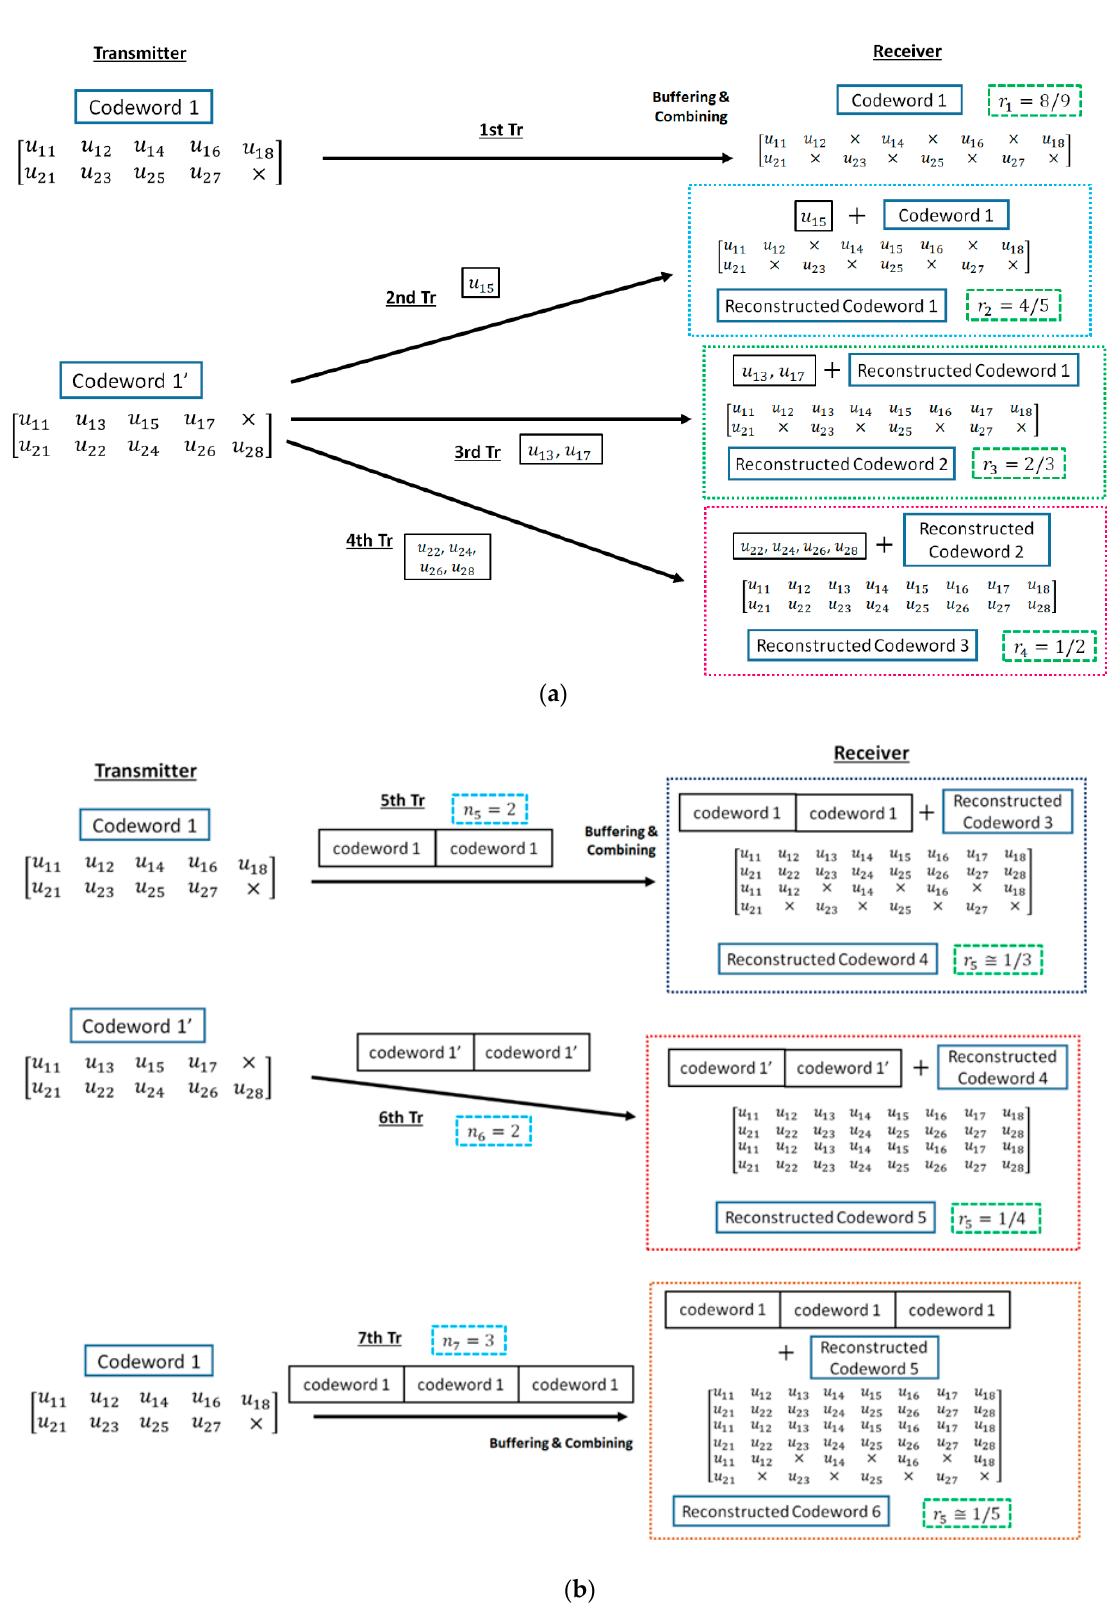
Figure 4. Method of reconstructing decomposable codes. ( a ) 1/2 ≤ r i ≤ 8/9; ( b ) r i ≤ 1/2